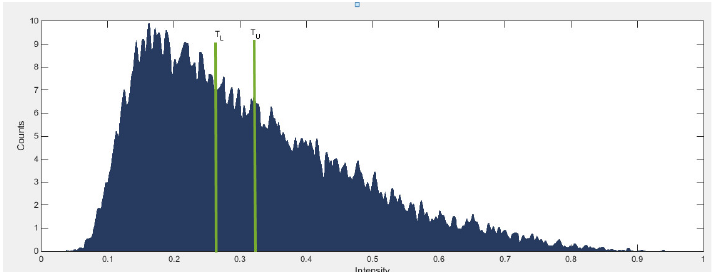
Figure 12. The histogram is divided into two threshold levels, which are shown by vertical bars. The lower threshold level T L is determined by subtracting the mean value of each edge of the histogram from the mean value of the picture, whereas the upper threshold level T U is determined by multiplying the standard deviation by 0.9 and subtracting it from the mean value of the image.